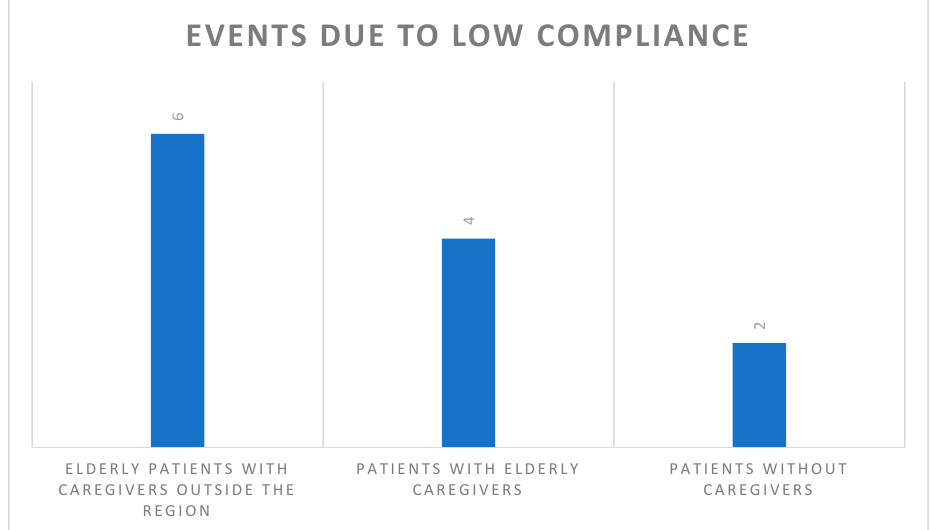
Figure 1. The total number of events due to low compliance was 12/3828.